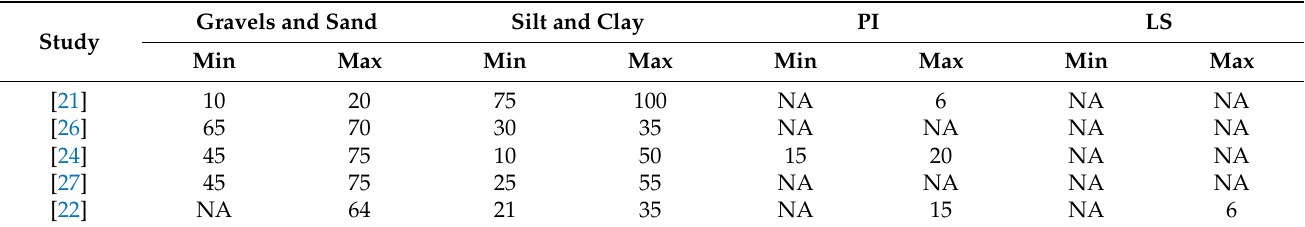
Table 1. Basic properties of soil and their ranges for usage in earth